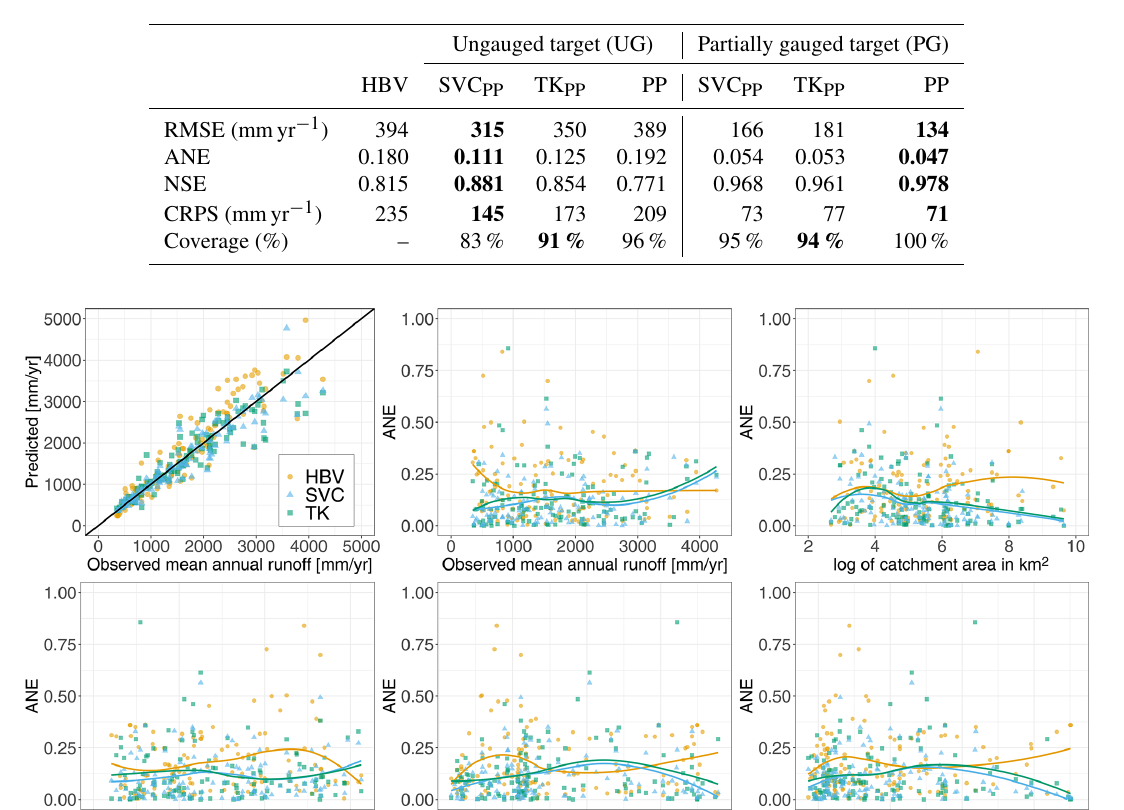
Table 2. Predictive performance for the cross-validation experiments when the target catchments are treated as ungauged (UG) and partially gauged (PG) for the HBV model, the suggested SVC model, and for Top-Kriging (TK). Subscript PP refers to the geostatistical preprocessing step. The results from the geostatistical preprocessing method (PP) are also included as reference (without any further analysis) for a better understanding of the other results. The best method for each evaluation criterion is marked in bold.